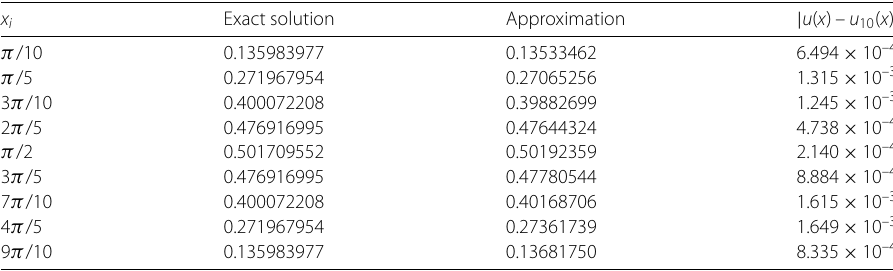
Table 1 Numerical results of BVP (4.3) at α = 1 using RKM